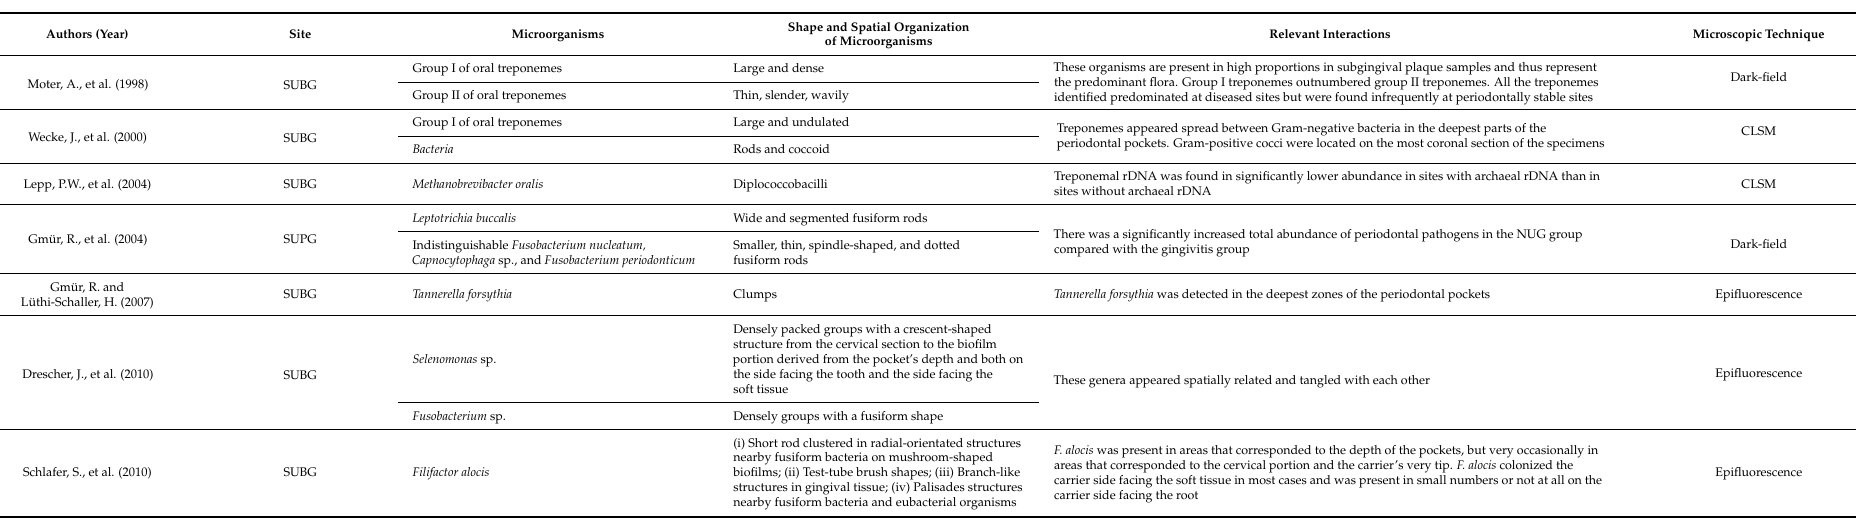
Table 2. A summary in terms of the location where the dental biofilm was collected, the microorganisms detected, their shape and spatial organization within the biofilm, the most relevant interactions detected, and the microscopic technique used in each study. The abbreviations can be found at the bottom of the